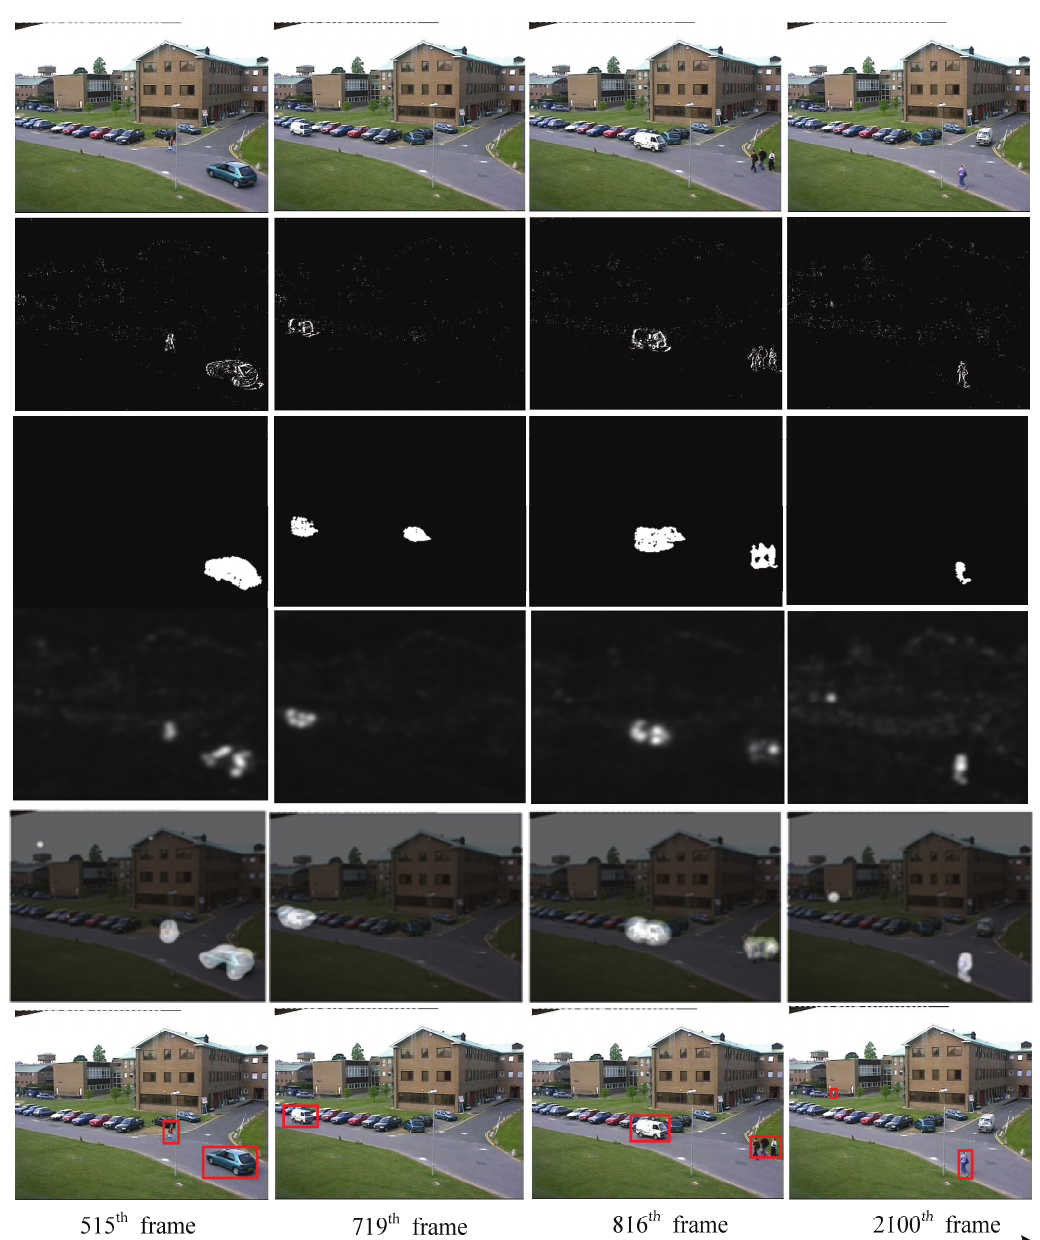
Comparison of two methods of spatio-temporal saliency maps in video sequences. The first row is the raw video of PETS2001 [45]; the second to fourth row are results produced by GMM [47], KDE [48], our method (HSC), mask of moving object extraction results by our method and box label of moving object extraction results by our method,